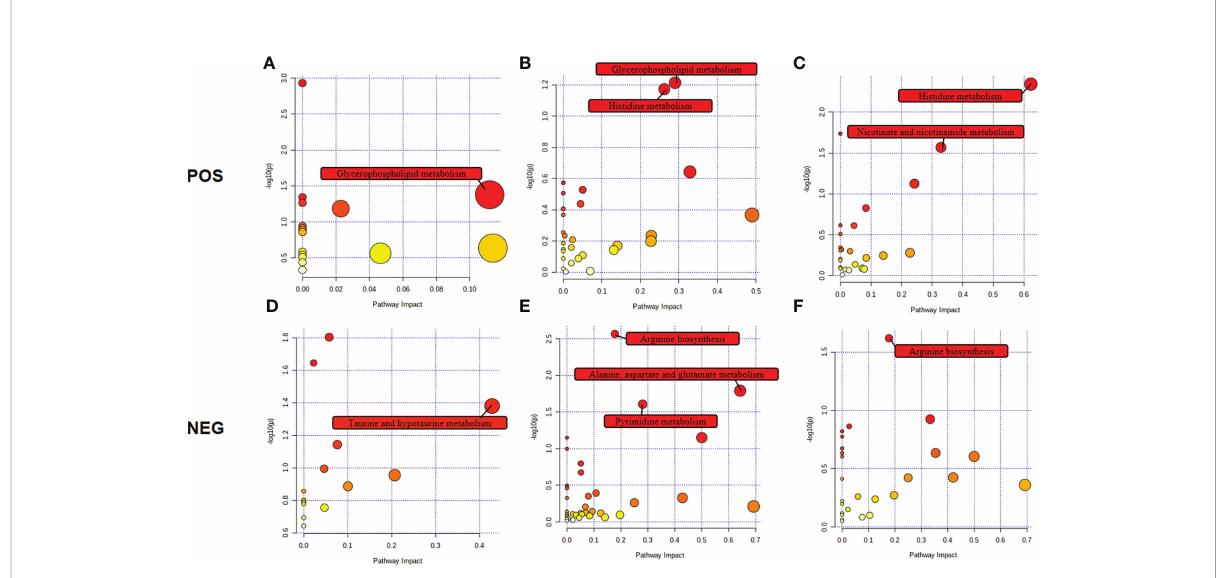
FIGURE 6 Pathway analysis of the identi fi ed differential metabolites in ESI+ mode and ESI − mode. Plots depict the pathway impacts of the key metabolites (x-axis) and the computed metabolic pathway as a function of – log ( P ) (y-axis) that different among 4 wpi vs. 4 con (A, D) , 8 wpi vs. 8 con (B, E) , and 8 wpi vs. 4 wpi (C, F)